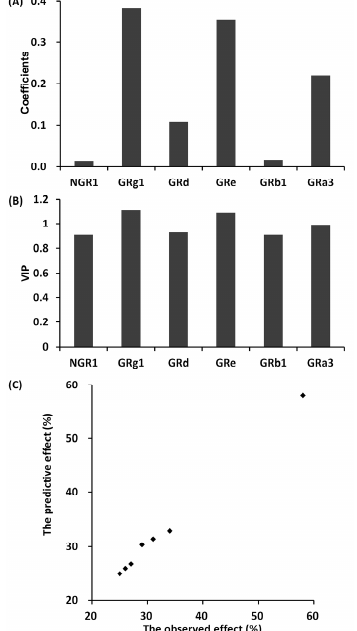
Figure 2. The partial least squares analysis between different individual saponin combinations and anti-platelet aggregation effect in vivo study in example 1. ( A ) The coefficients values of six saponins (GRb1, GRg1, GRd, NGR1, GRe, and GRa3); ( B ) The VIP values of six saponins (GRb1, GRg1, GRd, NGR1, GRe, and GRa3); ( C ) The diagram between the observed anti-platelet aggregation effect and the predictive anti-platelet aggregation effect.